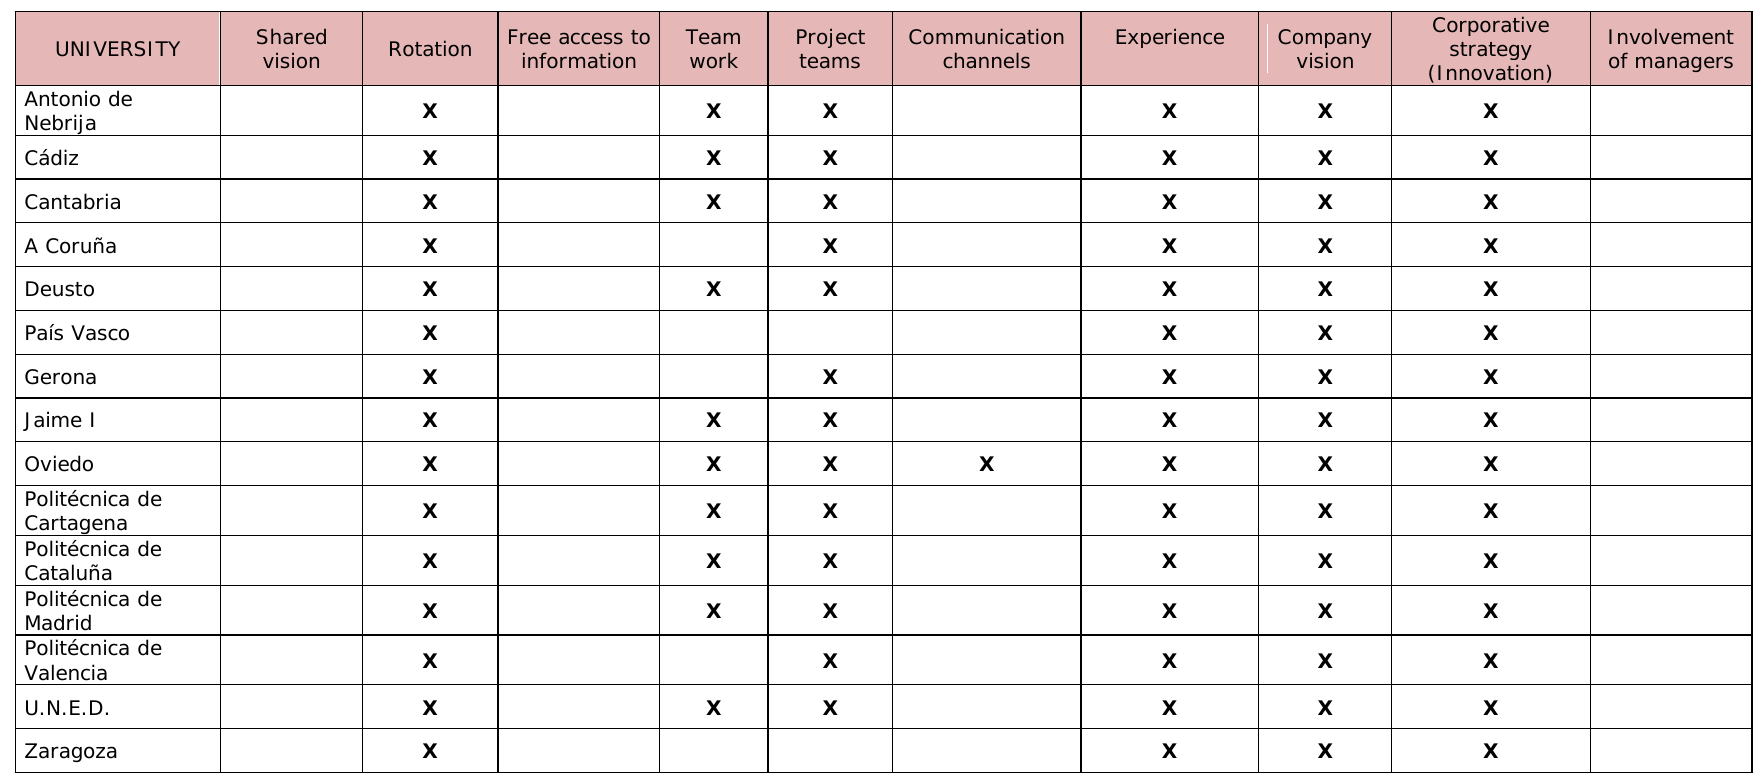
Table 2. “Required competencies in real business and Industrial Engineering